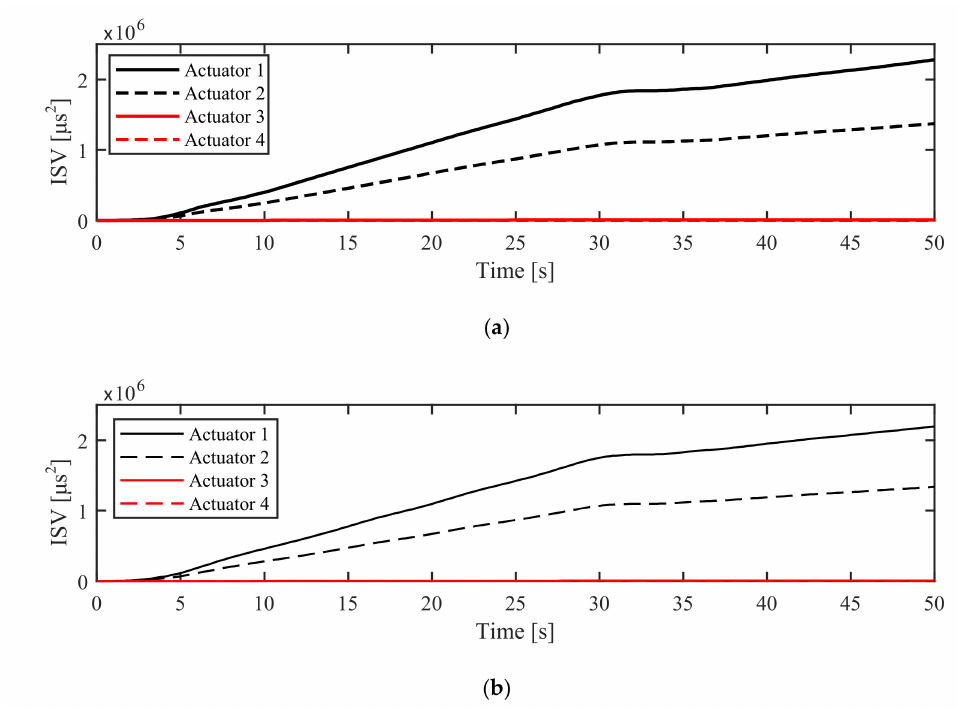
Figure 32. The performance indices in experimental AM mode: ( a ) ISV values of the proposed controller; ( b ) ISV values of the PID.